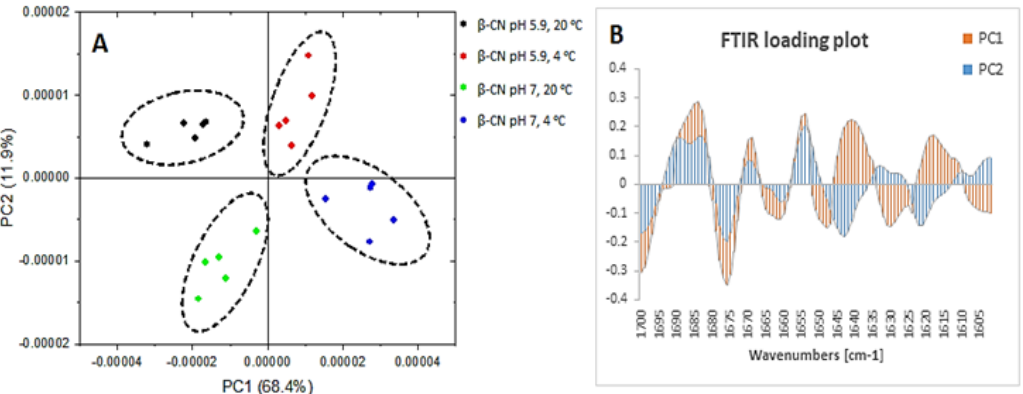
a,b,c Mean values within a row that do not share a common superscript letter are significantly different ( p ≤ 0.05); n/d = not detected.